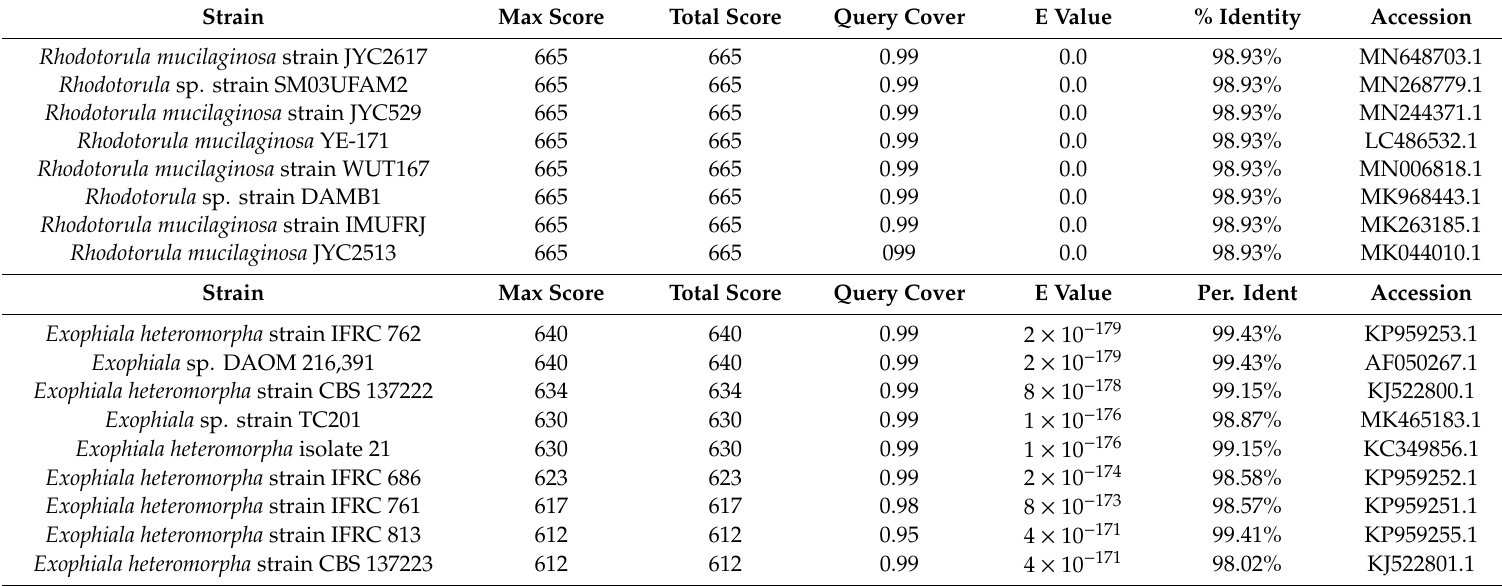
Table 1. Blast hits for both strains. The ITS2 region sequences obtained from the amplified PCR fragments were used to perform a BLAST in the NCBI